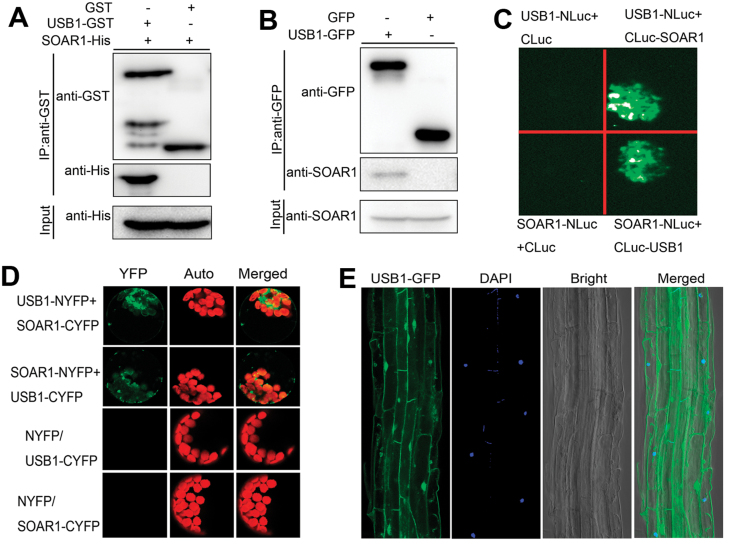
USB1 co-localizes and physically interacts with SOAR1 in both the nucleus and cytoplasm. (A) In vitro pull-down assay to test the direct interaction between SOAR1 and USB1 protein. The SOAR1-His proteins were incubated with immobilized GST or USB1–GST proteins, and the antibody against GST tag (IP:anti-GST) was used to pull down the purified USB1–GST or GST protein. Both the immunoprecipitated fractions and input were tested by immunoblotting with anti-His and anti-GST antibodies, respectively. (B) Co-immunoprecipitation (Co-IP) assay to test the interaction of USB1 with SOAR1 in Arabidopsis. Total proteins, extracted from the homozygous transgenic plants expressing GFP or USB1–GFP fusion protein (USB1–OE3), were immunoprecipitated with anti-GFP antibody (IP:anti-GFP). The immunoprecipitates and the input were tested by immunoblotting with anti-SOAR1 and anti-GFP antibodies. (C) Luciferase complementation imaging (LCI) assay to test the interaction between USB1 and SOAR1 using the N. benthamiana system. The coding sequences of USB1or SOAR1 were cloned into the N-terminal fragment of Luc (NLuc) and the C-terminal fragment of Luc (CLuc) to form USB1–NLuc(or SOAR1–NLuc) and CLuc–USB1 (or CLuc–SOAR1), respectively. The constructs pairs of USB1–NLuc/CLuc–SOAR1 and CLuc–USB1/SOAR1–NLuc were co-injected into N. benthamiana leaves, and the Luc signals were observed 72 h after infiltration. The combinations of USB1–NLuc/CLuc and SOAR1–NLuc/CLuc vectors were used as negative controls. (D) Bimolecular fluorescent complementation imaging (BiFC) assay using yellow fluorescent protein (YFP) to test the interaction between USB1 and SOAR1 in Arabidopsis mesophyll protoplasts. The coding region of USB1 or SOAR1 was fused to the N-terminus of YFP (USB1–NYFP or SOAR1–NYFP), or to the C-terminus of YFP (USB1–CYFP or SOAR1–CYFP). The constructs pairs (as indicated) were co-transformed into Arabidopsis wild-type (Col-0) mesophyll protoplasts. The combinations of NYFP /SOAR1–CYFP or USB1–CYFP were used as negative controls. The YFP fluorescence was imaged under a confocal laser scanning microscope. YFP, YFP signal; Auto, chloroplast autofluorescent signal; Merged, merged image of the YFP signal with the chloroplast autofluorescent signal. (E) Transgenic expression of the USB1–GFP fusion protein in whole Arabidopsis plants, showing that the USB1–GFP fusion protein (left) is localized to both the nucleus and cytoplasm in the root of a transgenic complementation line (the line Com11-1, see Supplementary Fig. S5) expressing 35S::USB1-GFP in the usb1-1 background. Note that the expression level of USB1 in the Com11-1 transgenic line is slightly higher than that in the wild-type plants (Supplementary Fig. S5). The nuclei are indicated by DAPI staining. Bright, bright field; Merged, merged image of the DAPI signal with the USB1–GFP signal in the bright field. (F) Transient expression of the USB1–GFP fusion protein in the Arabidopsis protoplasts, showing the nuclear–cytoplasmic dual localization of USB1. Left panels: the signal of the USB1–GFP fusion protein overlaps the signal of a nuclear-localized bHLH (basic helix–loop-helix) transcription factor FBI1/HFR1 (FBI1–RFP) tagged with mCherry (a red fluorescent protein) in the nuclear portion (Merged, merged image of USB1–GFP with FBI1–RFP in the bright field). Right panels: the signal of the USB1–GFP fusion protein completely overlaps the signal of the cytosolic–nuclear dual-localized SOAR1–RFP (SOAR1 tagged with mCherry) fusion protein (Merged, merged image of USB1–GFP with SOAR1–RFP in the bright field). Bright, bright-field. (G) BiFC assays in the N. benthamiana leaves, indicating that USB1 interacts with SOAR1 in both the nucleus and cytoplasm. The coding regions of USB1 and SOAR1 were fused to the N-terminus of YFP and the C-terminus of YFP to form USB1–NYFP and SOAR1–CYFP, respectively. The construct pairs (as indicated) were co-infiltrated into N. benthamiana leaves. YFP fluorescence was detected in N. benthamiana leaves co-infiltrated with combinations of USB1–NYFP and SOAR1–CYFP. The combination of NYFP/SOAR1–CYFP was used as a negative control. The YFP fluorescence was imaged under a confocal laser scanning microscope. YFP, YFP signal; DAPI, staining for the nucleus; Merged, merged image of the YFP signal with the DAPI signal. All the experiments were repeated five times with similar results.